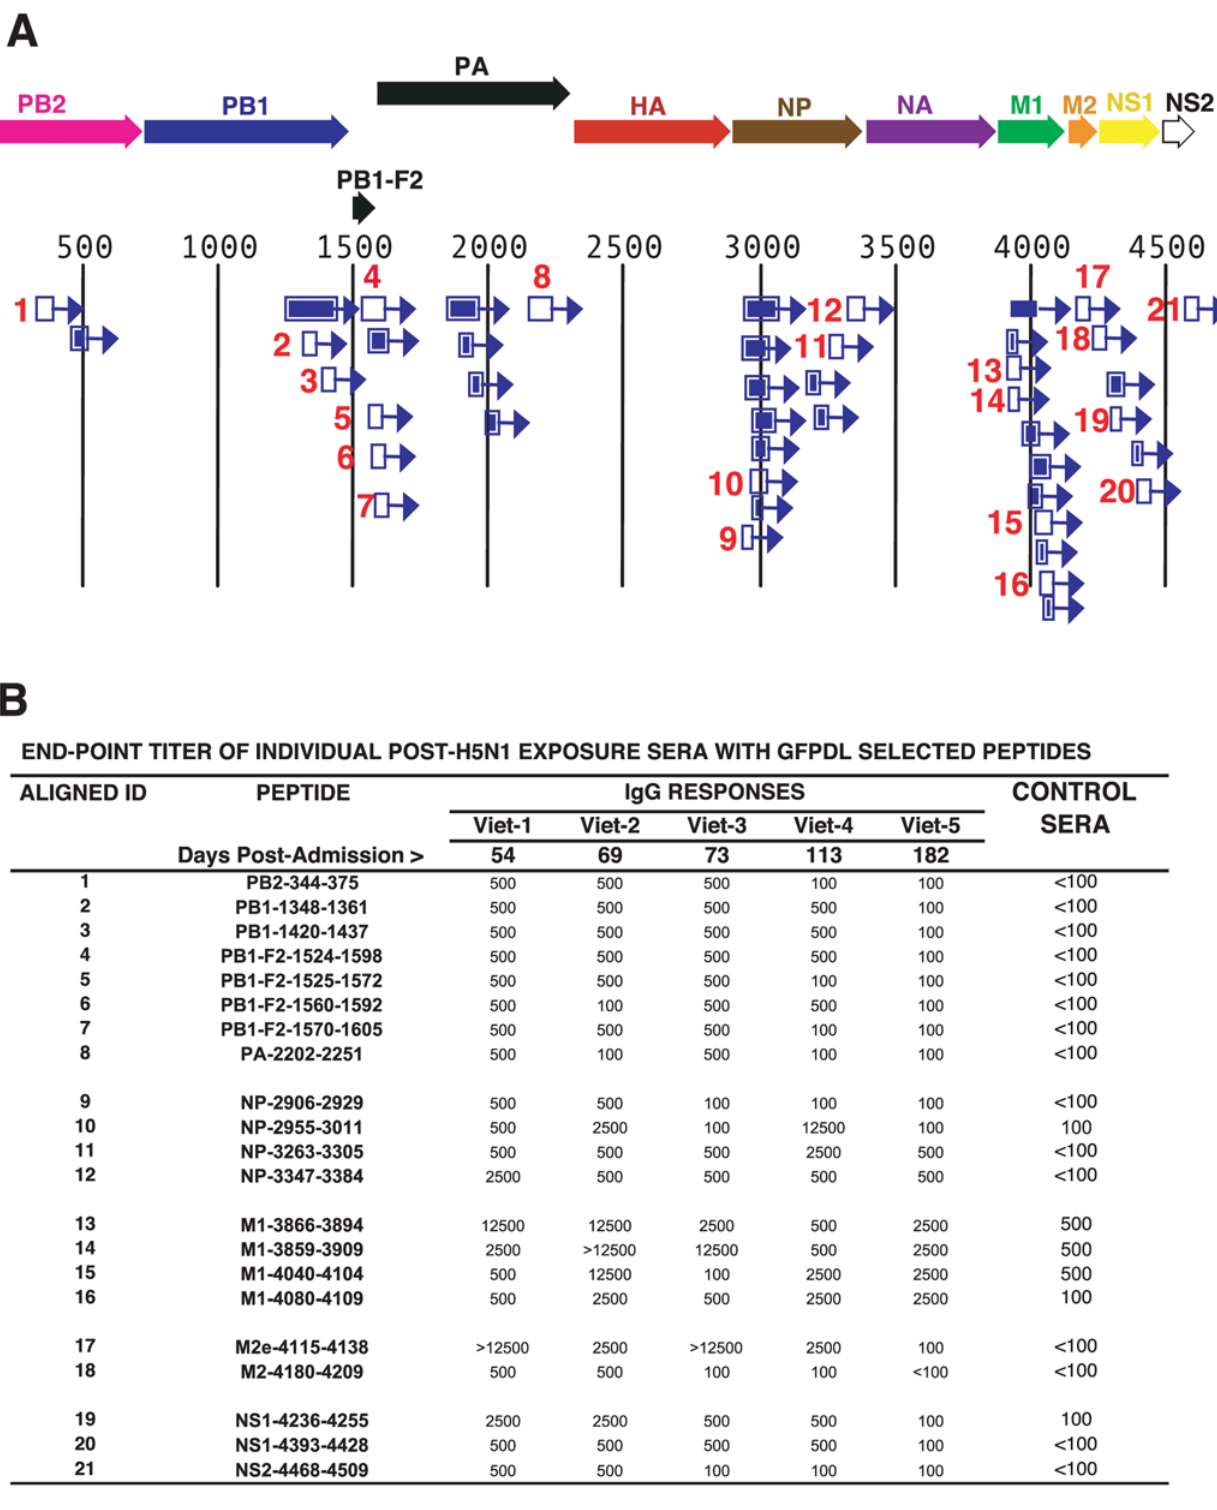
Figure 5. Antibody epitopes in H5N1 internal proteins (FLU-6) recognized by pooled sera from H5N1 infected individuals. (A) Schematic alignment of the peptides identified using GFPDL (H5N1-FLU-6) expressing all internal proteins of influenza A/Vietnam/1203/2004. The predicted influenza encoded proteins are numbered according to the complete proteome (Figure S1). Bars with arrows indicate identified inserts in the 5 9 –3 9 orientation. Numbered segments represent high frequency clones ( $ 5; Table S1). These peptides were expressed and purified from E. coli or were chemically synthesized and the numbers correspond to the peptide identifiers in the ELISA assay in (B). (B) Reactivities of sera from individual H5N1-infected patients (Viet 1–5) or sera from healthy Vietnamese adults against peptides derived from: PB2 (1); PB1 (2–3); PB1-F2 (4–7); PA (8); NP (9–12); M1 (13–16); M2e (17); M2 (18); NS1 (19–20); and NS2 (21).